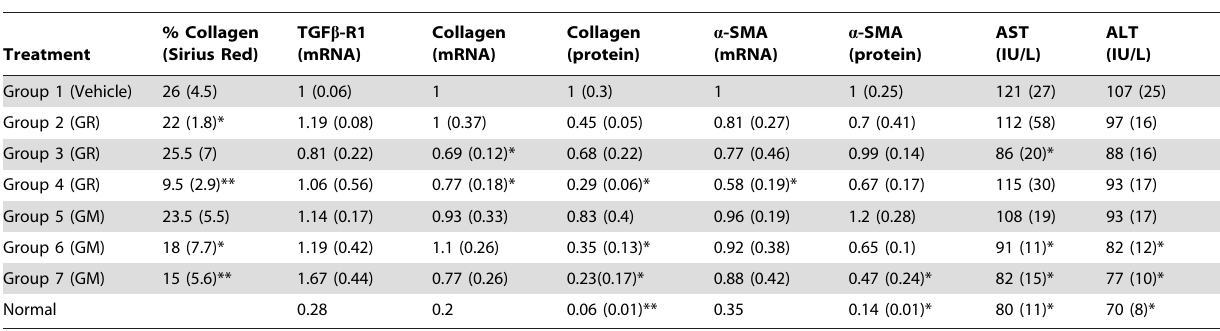
Normal % Collagen is percent area of biopsy stained with Sirius red. TGFb-R1, Collagen, and a-SMA mRNA were assessed by RT PCR and Collagen and a -SMA protein assessed by Western Blot (protein for TGFb-R1 was not evaluated). Data is normalized to Group 1 (Vehicle). Data is presented as mean and standard deviation in parentheses. Two sided t-text evaluated for Groups 2–7 as compared to Group 1 (Vehicle). *p , 0.05;